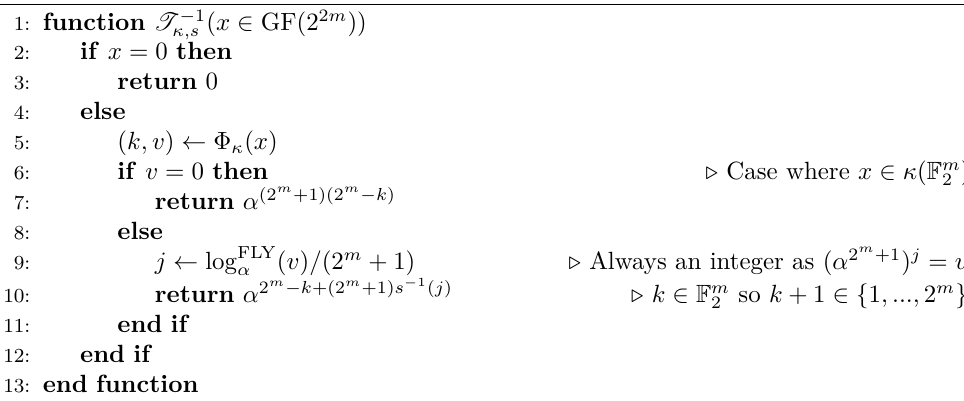
Algorithm 4 A TKexp